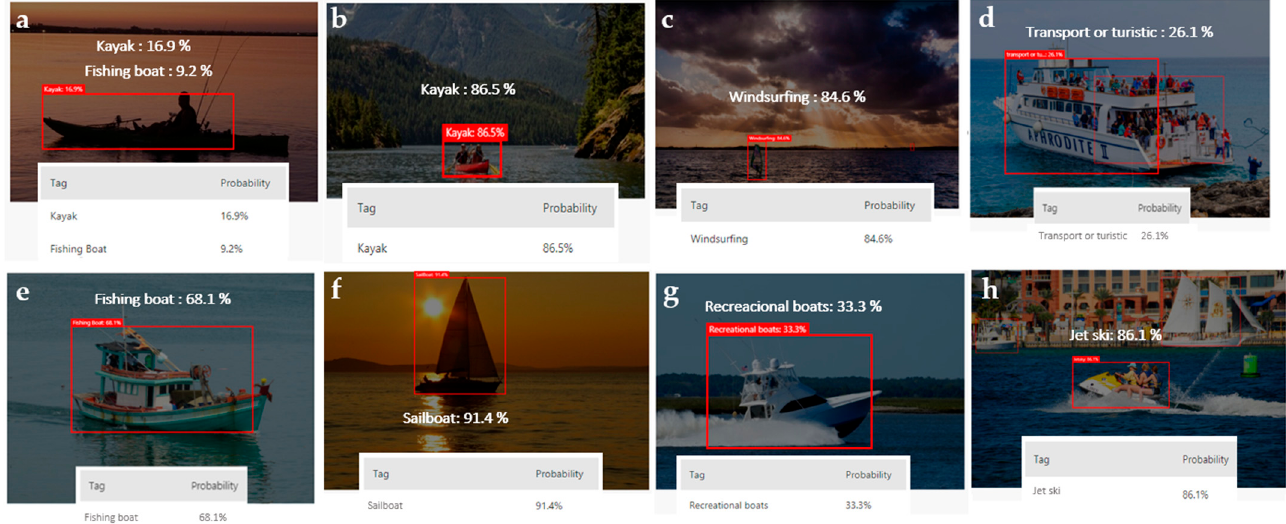
Figure 7. Performance of the cloud custom model object detection in discerning different boat types (( a ): Kayak, ( b ): Kayak, ( c ): Windsurfing board, ( d ): Transport or turistic boat, ( e ): Fishing boat, ( f ): Sailboat, ( g ): Recreational boat, ( h ): Jet ski).